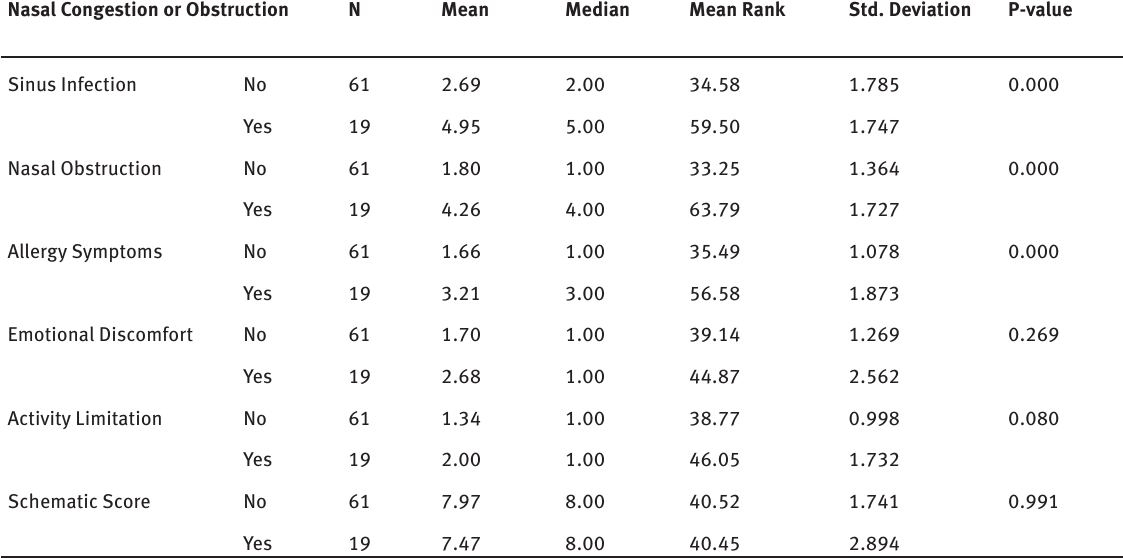
Table 2: Comparison of quality of life scores between people with nasal obstruction and those no nasal obstructions using the Nonparametric Mann-Whitney U